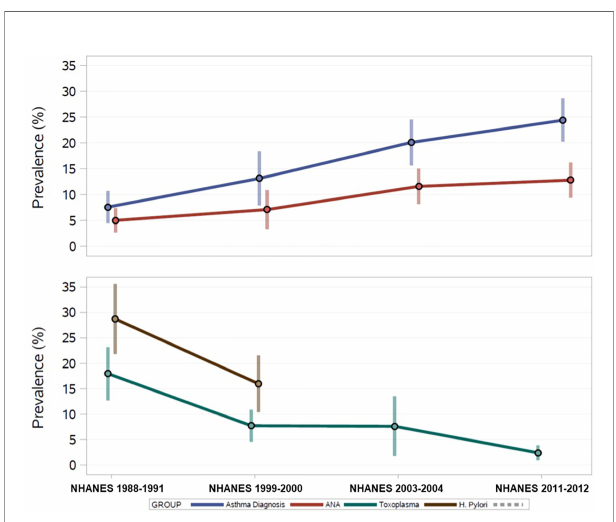
FIGURE 2 | U.S. Prevalence Estimates of ANA, Asthma, and Persistent Infections over 25 years from the National Health and Nutrition Examination Survey,